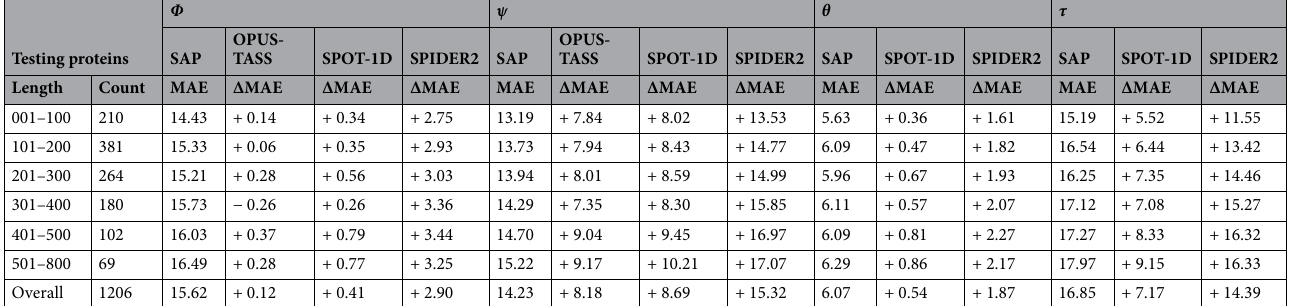
Table 7. Performance of SAP, OPUS-TASS, SPOT-1D, and SPIDER2 when our testing proteins are grouped based on their lengths. In the table, ΔMAE of a system (e.g. OPUS-TASS, SPOT-1D or SPIDER2) is its MAE minus the MAE of SAP. As such, the greater the value of ΔMAE, the worse the performance of the system w.r.t. the performance of SAP. The horizontal lines in SAP columns split those columns such that the upper parts have MAE values less than the overall MAE values and the lower parts have MAE values greater (a slight exception for